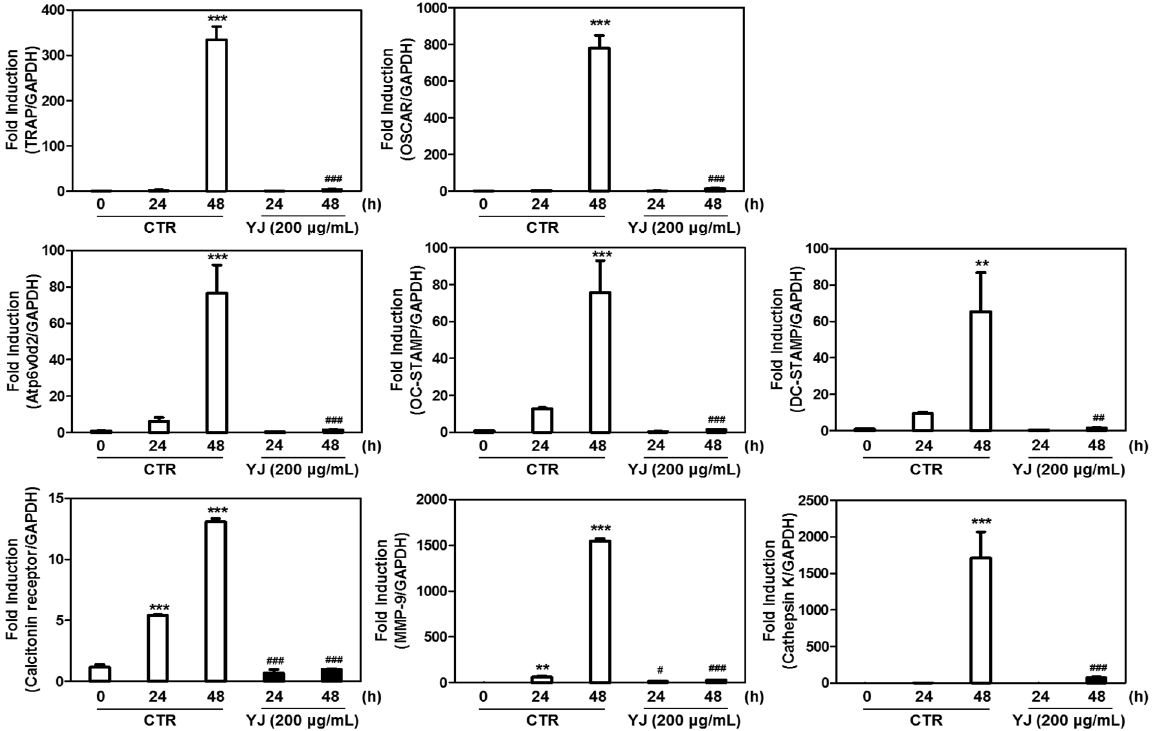
Figure 7. YJ suppresses RANKL-mediated expression of osteoclast-related genes in BMMs. BMMs were treated with M-CSF and RANKL in the presence or absence of YJ (200 µ g/mL). Total RNA was isolated from cells and the mRNA expression of the indicated gene was analyzed by quantitative real-time RT-PCR. The data are presented as the mean ± SD of three independent experiments. ** p < 0.01, *** p < 0.001 versus the control at 0 h; # p < 0.05, ## p < 0.01, ### p < 0.001 versus the control at each time point. TRAP, tartrate resistant acid phosphatase; OSCAR, osteoclast-associated receptor; Atp6v0d2, vacuolar-type H + -ATPase V0 subunit D2; OC-STAMP, osteoclast stimulatory transmembrane protein; DC-STAMP, dendritic cell-specific transmembrane protein; MMP-9, matrix metalloproteinase-9.